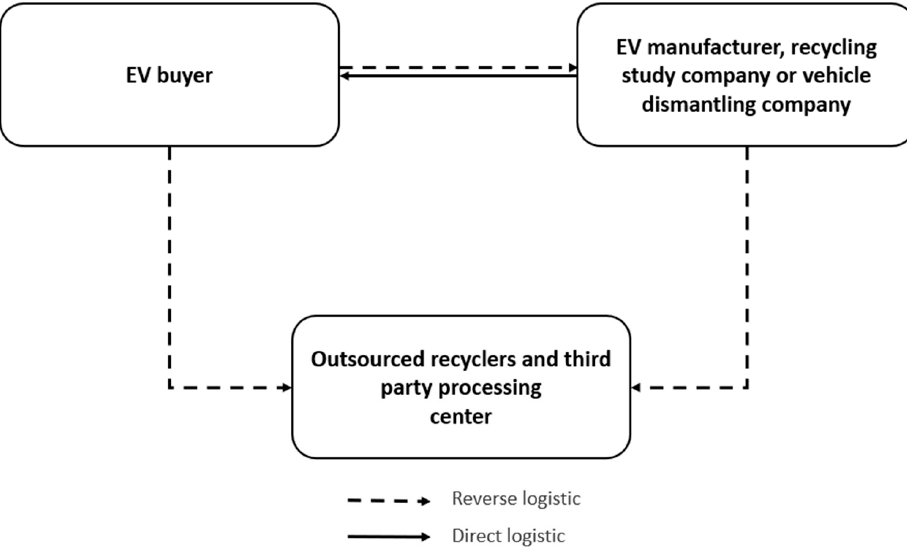
Figure 6. Another lithium-ion battery recycling route option. Adapted from [33].